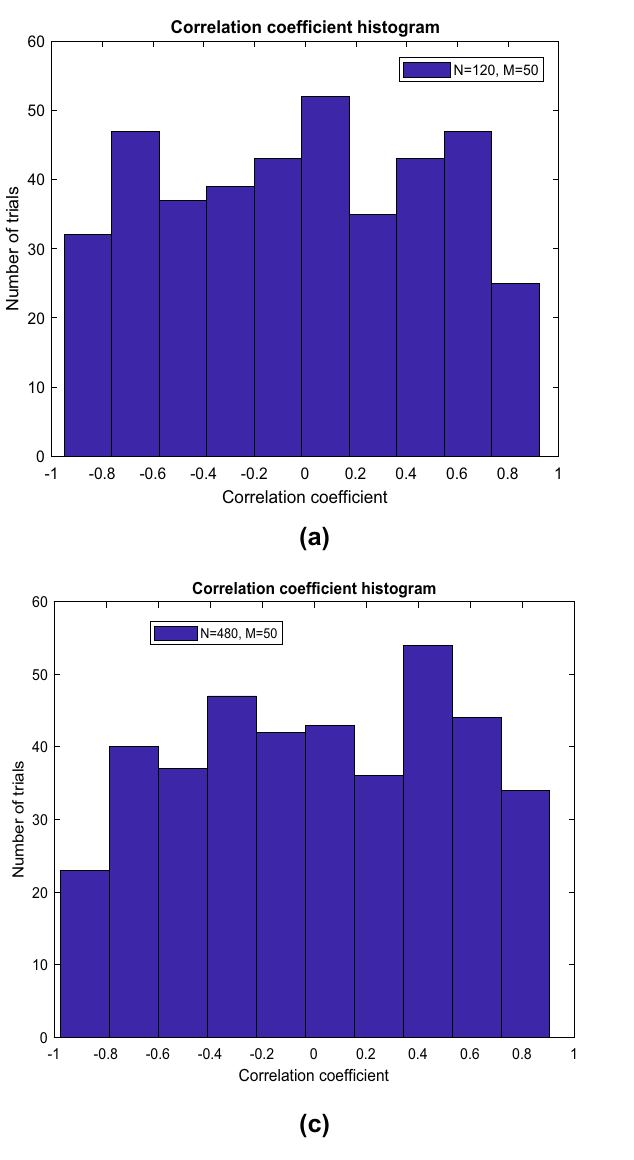
Fig. 5 Distribution of the correlation coefficient between the actual data and the estimated data for a N = 120, M = 50, b N = 240, M = 50, c N = 480, M = 50, d N = 960, M = 50. None of the distributions are